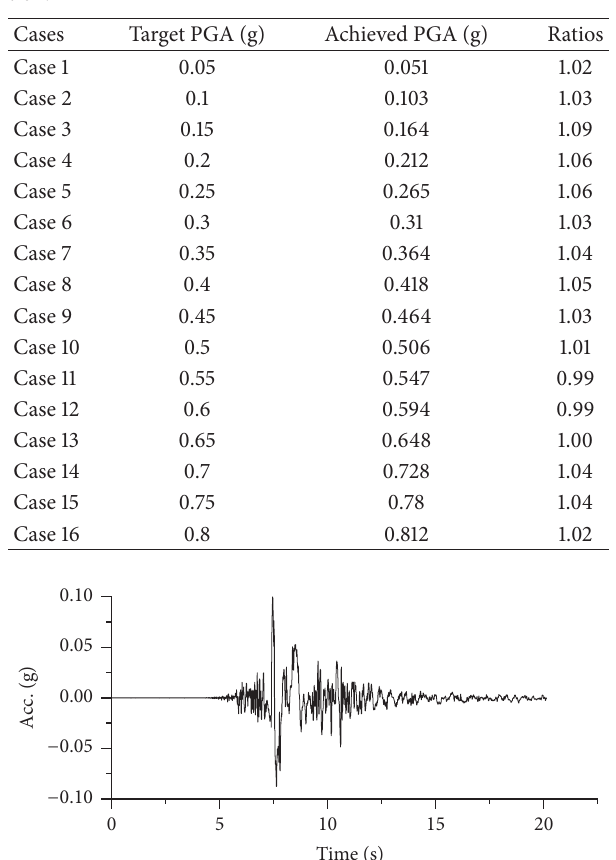
Table 4: Comparison of target and achieved peak ground accelera- tion.